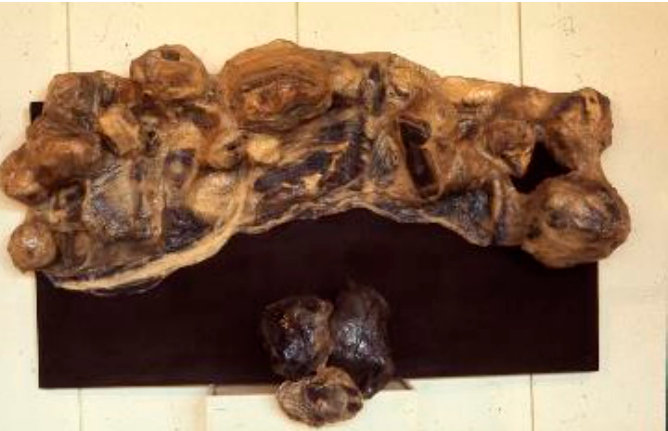
Figure 6. Alina Szapocznikow, Alina’s Funeral , 1970, polyester resin, glass wool, photographs, wood, gauze, artist’s clothing, 135 × 210 × 50 cm. Muzeum Narodowe w Krakowie. © ADAGP, Paris. Courtesy of The Estate of Alina Szapocznikow/Piotr Stanislawski/Galerie Loevenbruck, Paris/Hauser & Wirt.